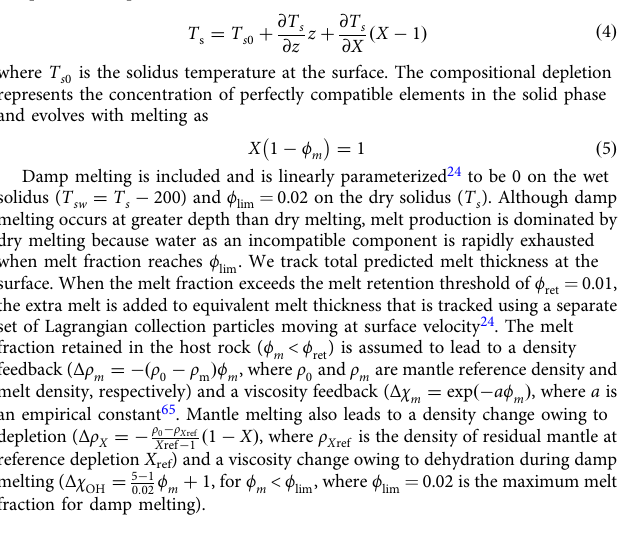
Table 1). The solidus temperature is parameterized as a function of depth ( z ) and compositional depletion ( X ) (ref. 64